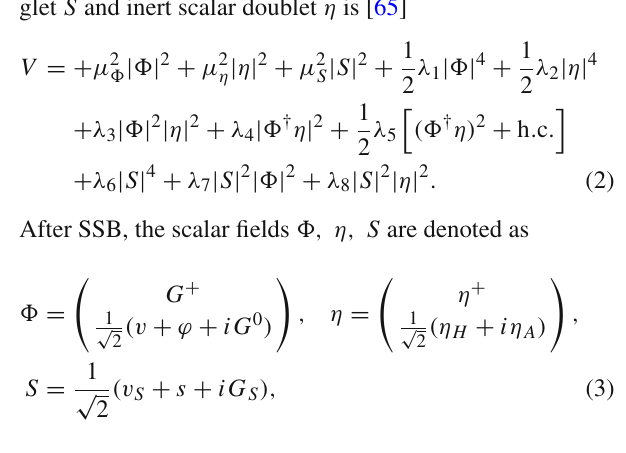
Table 1. Here, the right-handed neutrinos N (cid:3) ((cid:3) = e , μ,